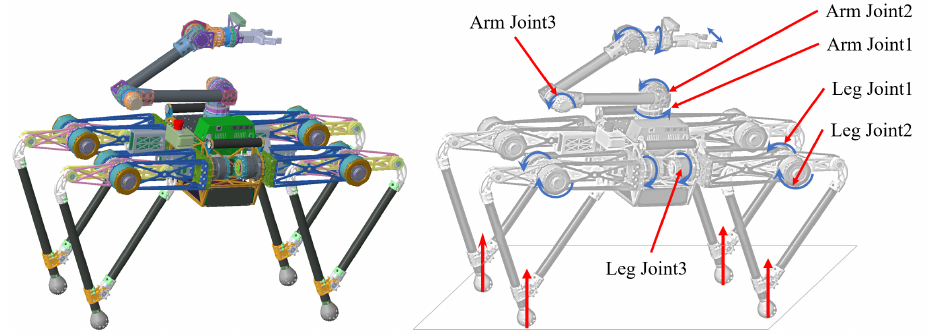
Figure 3. The SY legs quadruped robot with a